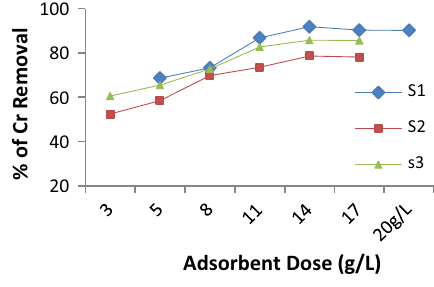
Fig. 4 Effect of adsorbent dose on Cr removal